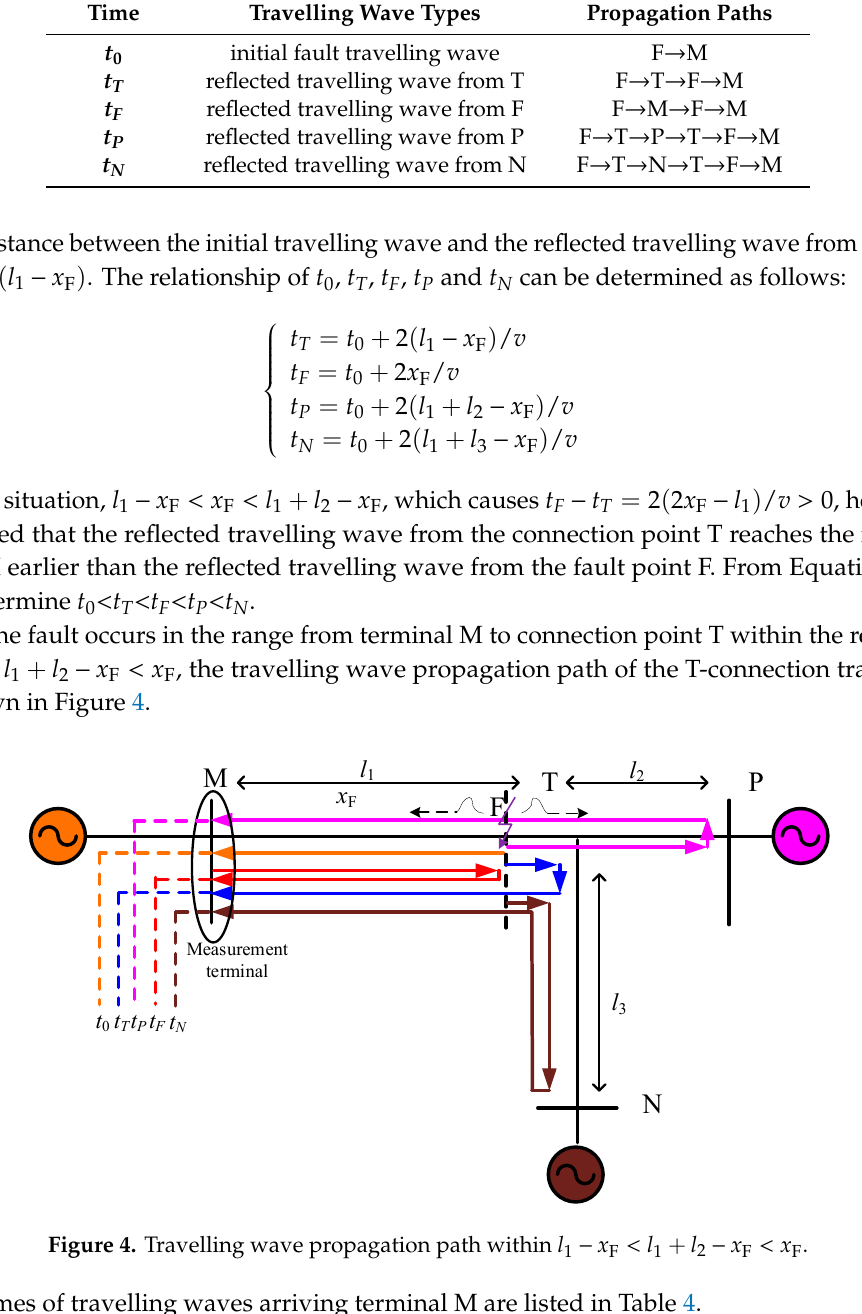
Figure 4. Travelling wave propagation path within 1 F 1